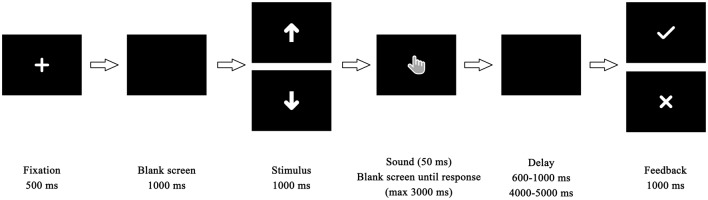
Time course of stimulus presentation in the time estimation task.